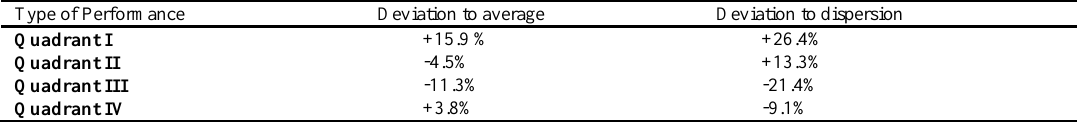
Table 1. Average deviation to expected performance (Folgado et al., 2013; Folgado et al., 2015) Type of Performance Deviation to average Deviation to dispersion Quadrant